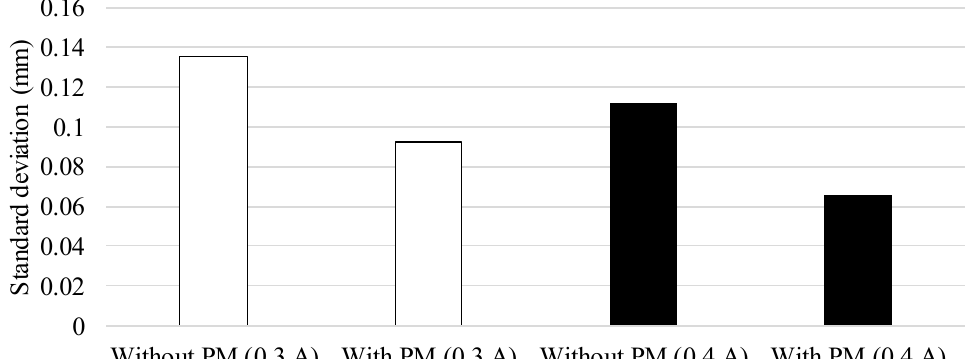
Figure 9. Displacement standard deviation of the levitation direction of each horizontal steady current.